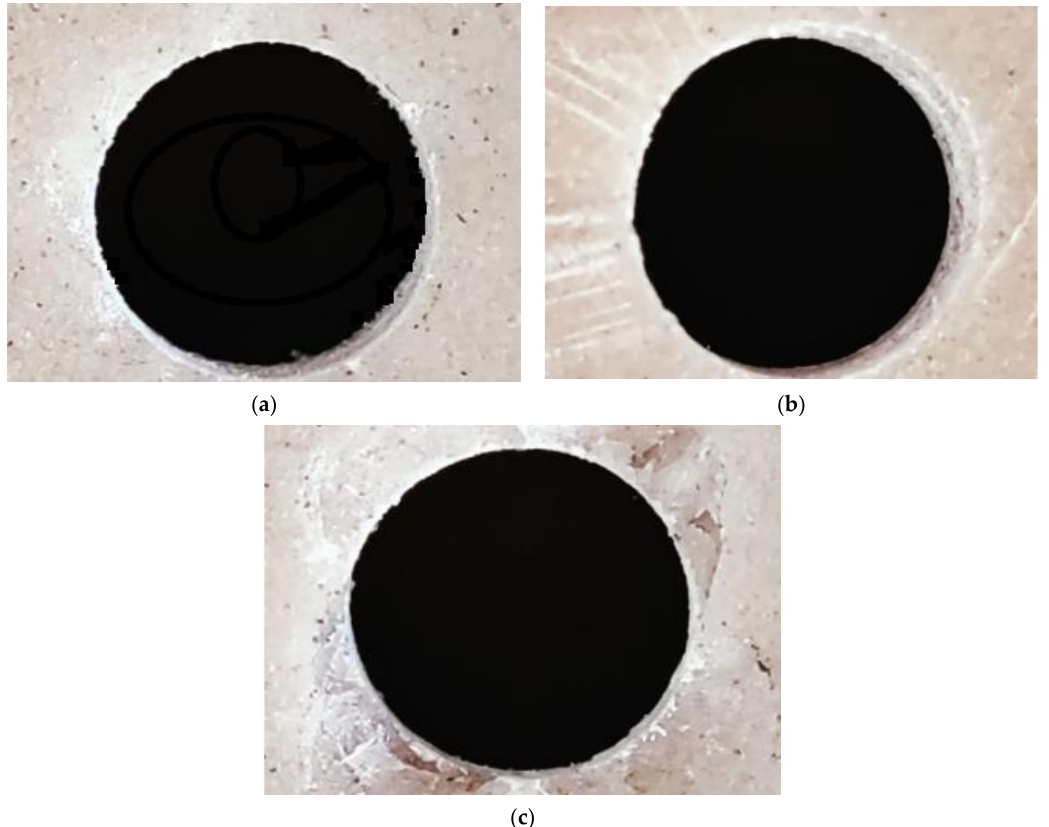
Figure 16. Hole quality assessment using light microscopy. ( a ) A 6 mm diameter drill, ( b ) 8 mm diameter drill, ( c ) 10 mm diameter drill. diameter drill, ( c ) 10 mm diameter